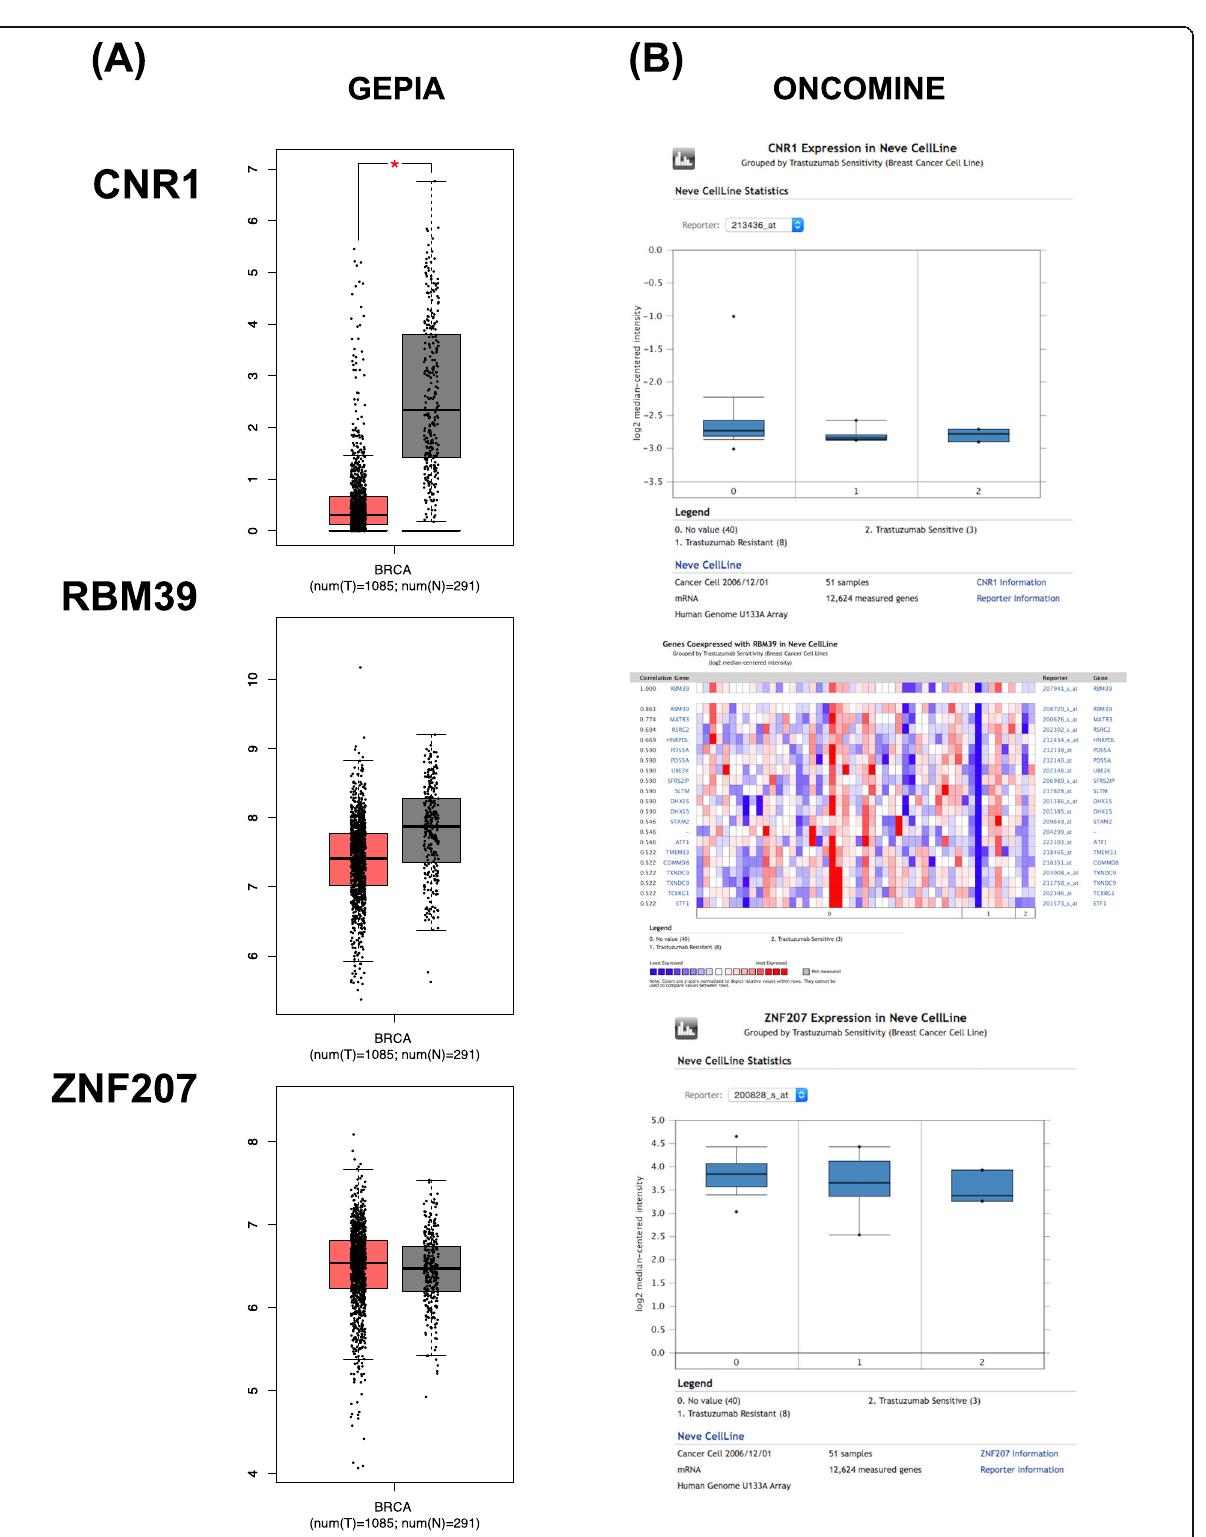
Fig. 3 CNR1, RBM39, and ZNF207 mRNA levels in a . Breast cancer samples, analyzed by GEPIA and b Trastuzumab resistance breast cancer samples, analyzed by